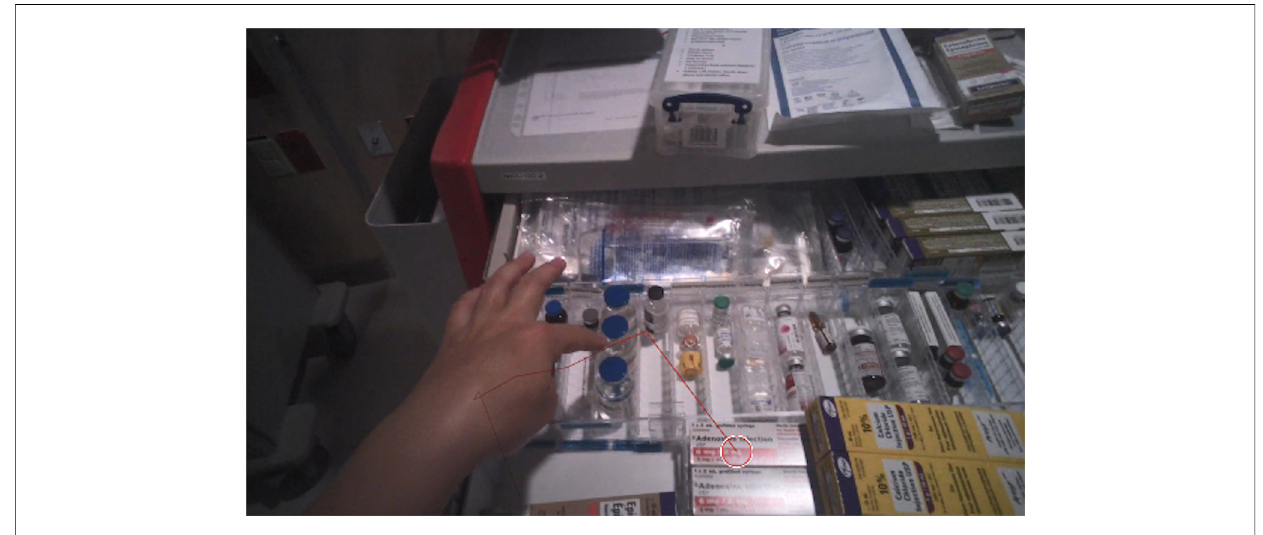
FIGURE 3 Still image of eye-tracking during equipment search (circle indicates current visual attention, lines delineating gaze